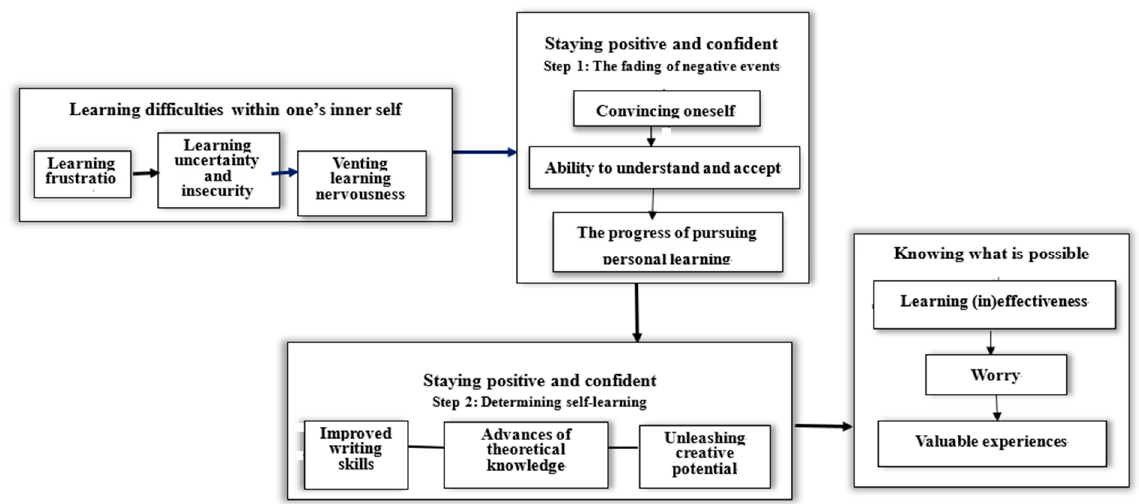
Figure 1. The process of developing psychological resilience in a virtual practicum.